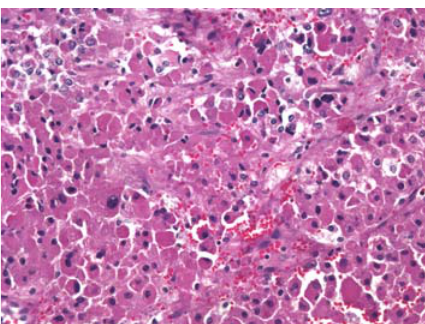
Figure 3: 200x magnification: the tumor is composed entirely of large cells with abundant granular eosinophilic cytoplasm and indistinct cellular boundaries. Mild nuclear atypia is seen. Mitotic figures are not